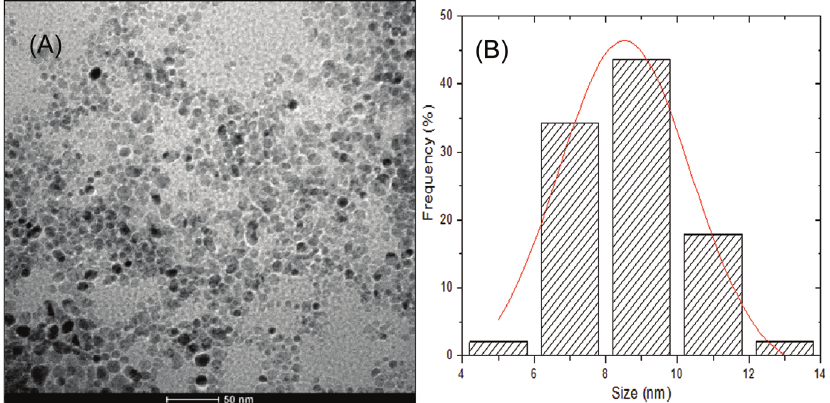
Figure 2: TEM image (A) and the particle size distribution (B) of Ni-B amorphous nanoparticles prepared by continuous flow in microfluidic reactor at the flow rate of 15